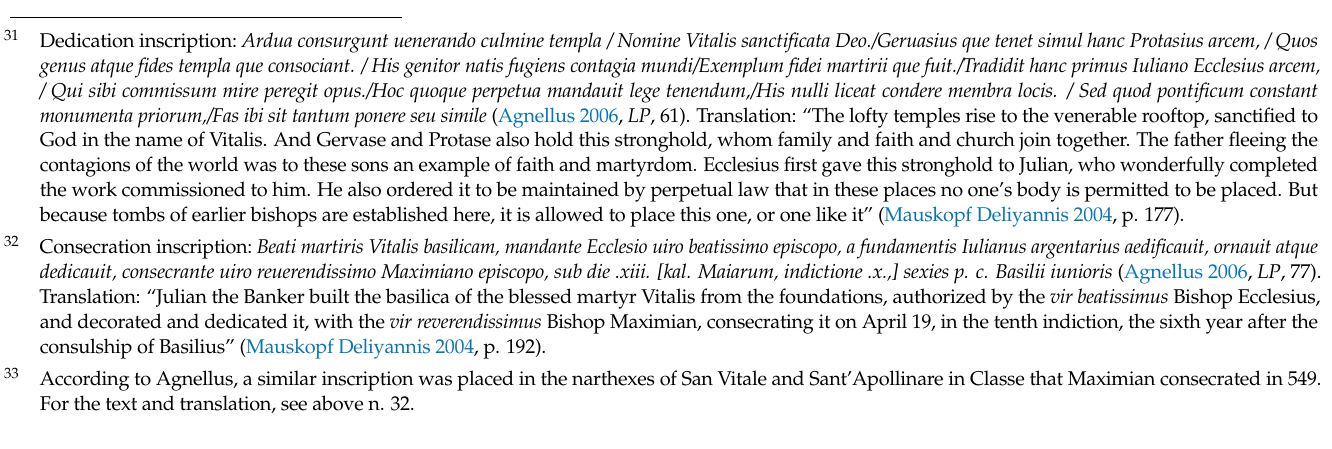
Figure 9. Matroneum northern windows, Basilica of San Vitale, Ravenna (photo: courtesy of Isti- tuzione Biblioteca Classense, Ravenna, Fondo Ricci).